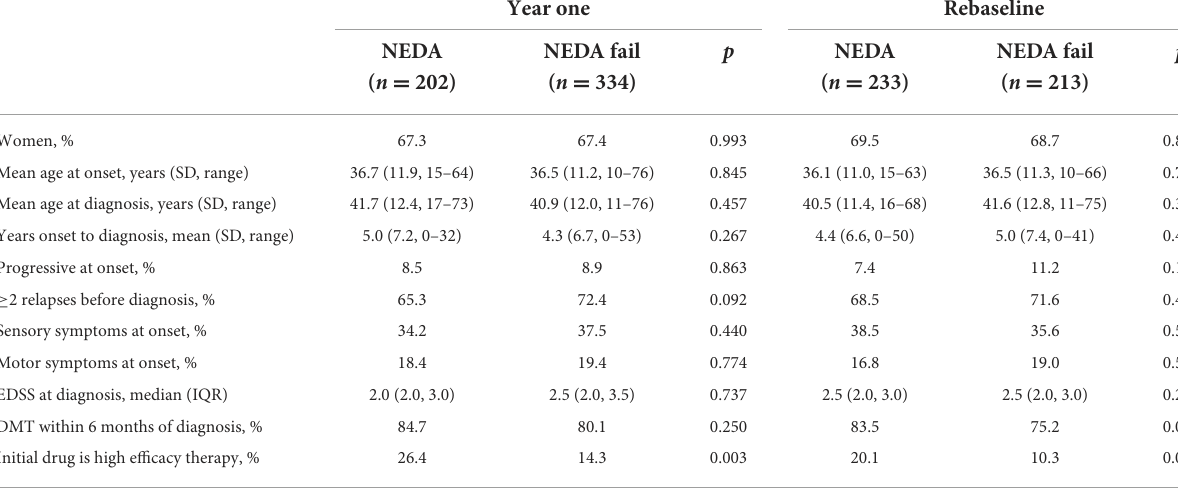
TABLE 2 Disease characteristics and demographics in pwMS who did and did not achieve NEDA at year one and at rebaseline.